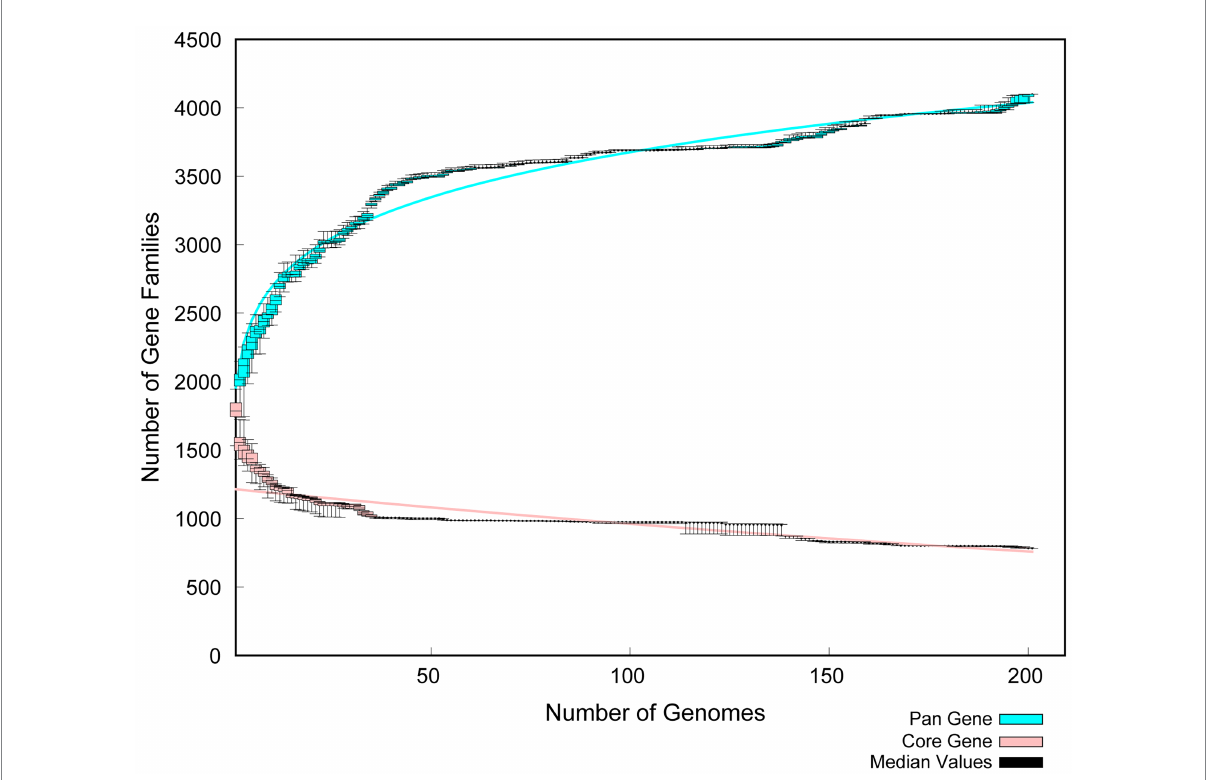
FIGURE 10 Comparative analysis of Pan Gene and Core Gene in Pediococcus